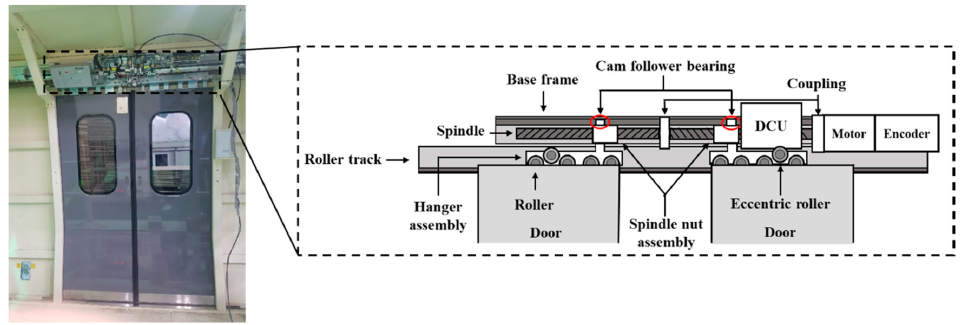
Figure 6. Components of a train door test rigs. Reproduced with permission from MDPI (Creative Commons Attribution License)